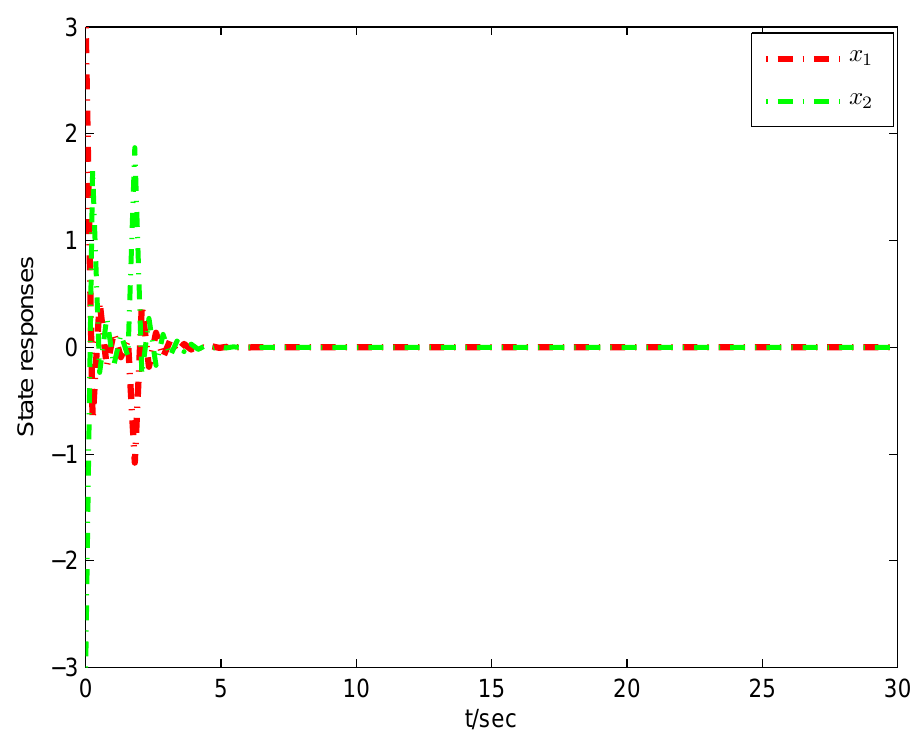
Figure 2. State trajectories of the fractional order neural network model (51) in Example